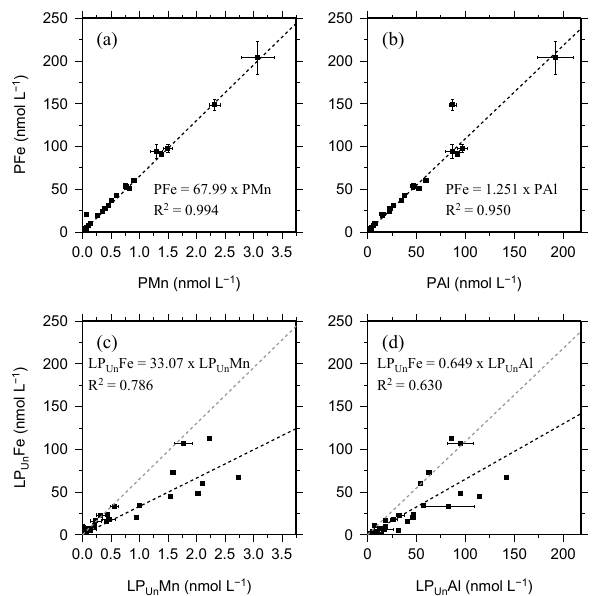
Figure 3. Relationship of the entire data set for the particulate frac- tion of Fe, Mn, and Al in particulates ( P ) retrieved using SAPS (a, b) and the leachable particulate fraction (LP Un ) estimated from un- filtered and dissolved seawater samples collected using OTE bot- tles (c, d) . Error bars represent the standard deviation of the anal- ysis. The linear regression of each relationship is illustrated by a dashed black line, the formula, and the R 2 . The grey dashed line in (c) and (d) represents the linear relationship of particulate trace meals ( P ) shown in (a) and (b)